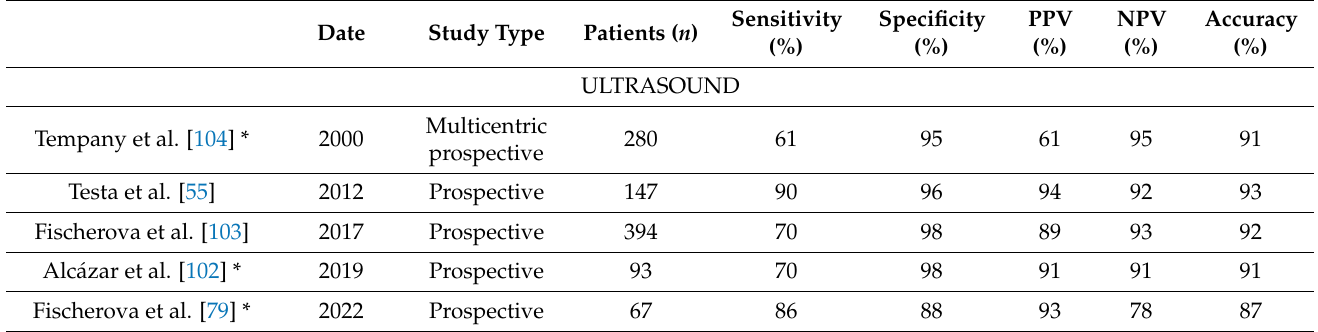
Table 5. Diagnostic accuracy of preoperative imaging techniques for detecting overall peritoneal